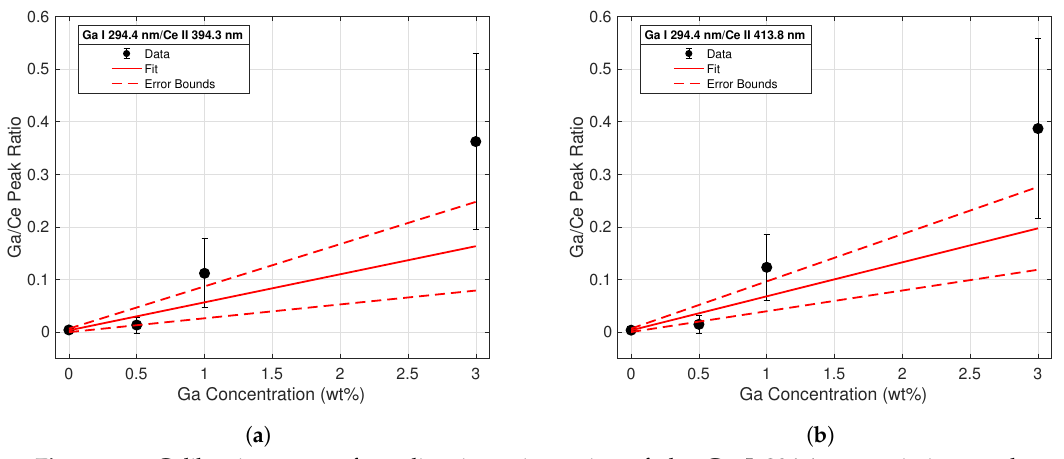
Figure 6. Calibration curve from line intensity ratios of the Ga I 294.4-nm emission to the ( a ) Ce II 394.3-nm ( b ) and the Ce II 413.8-nm emission lines. Table 1. Fitting parameters for calibration curves for the equation y = ax + band limit of detection (LOD).